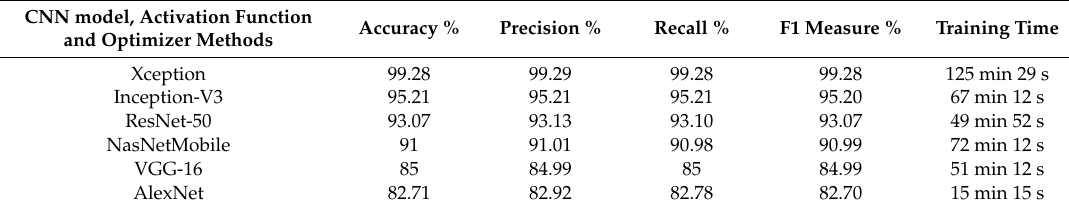
Table 10. Comparison of the e ff ectiveness and time consumption for classification models using Nadam and